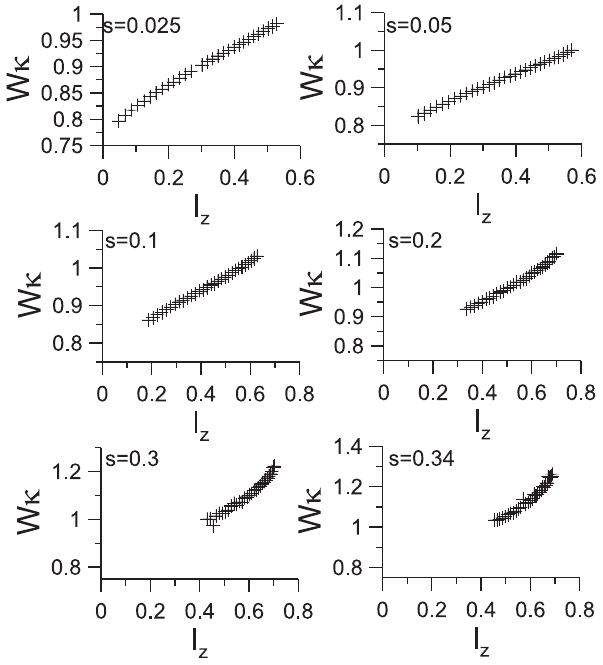
Fig. B3. W as a function of I z for various s (to substitute val- ues of W in the equation for dynamical jumps, one should take Frac (W/κ)